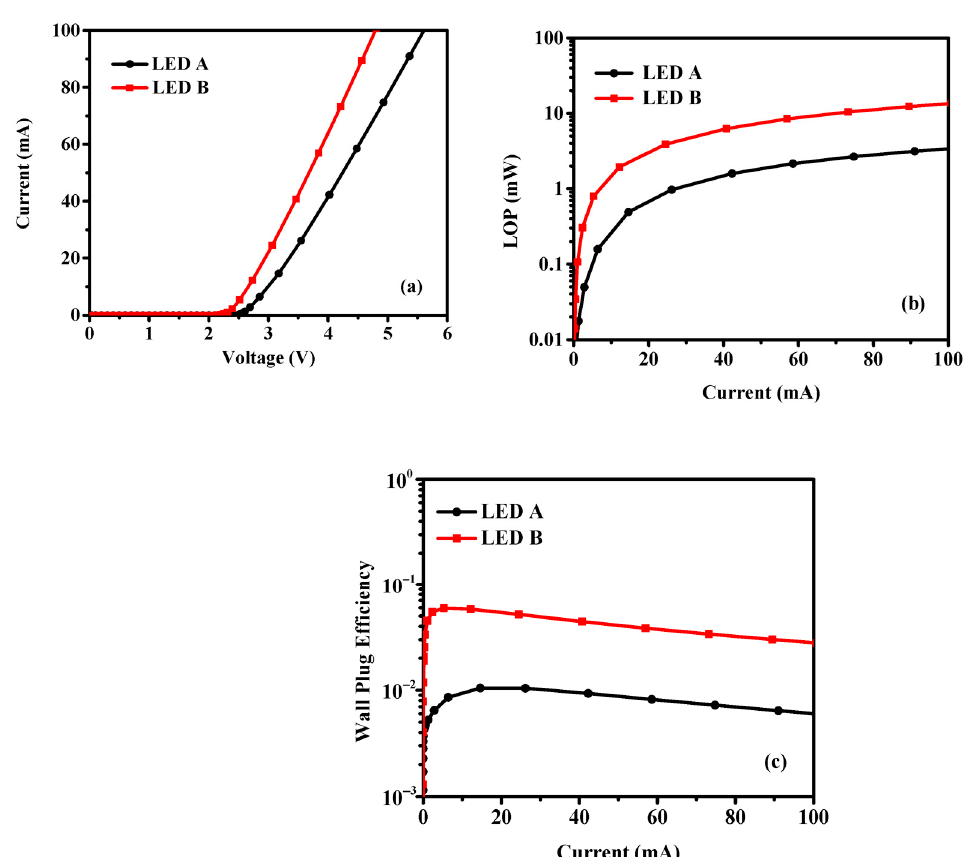
Figure 6. Advanced Physical Model of Semiconductor Device (APSYS) simulated results of LED A and LED B: ( a ) Voltage, ( b ) LOP and ( c ) WPE as a function of the injection direct